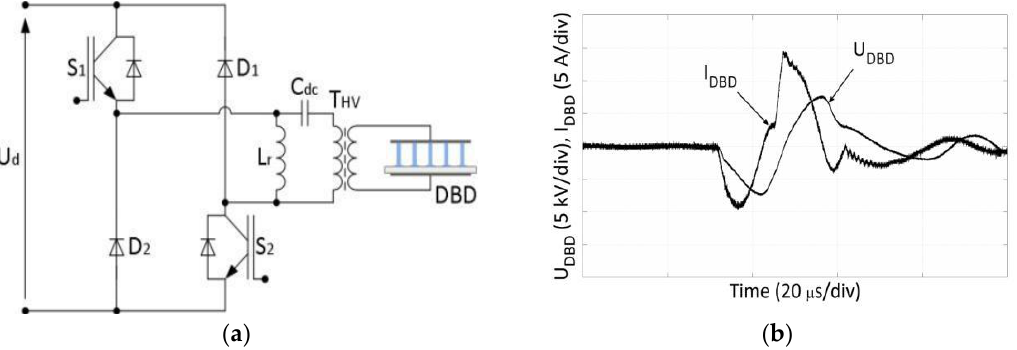
Figure 20. ( a) Diagonal bridge resonant converter for DBD reactor excitation, (b ) DBD current and Figure 20. ( a ) Diagonal bridge resonant converter for DBD reactor excitation, ( b ) DBD current voltage waveforms [56]. and voltage waveforms